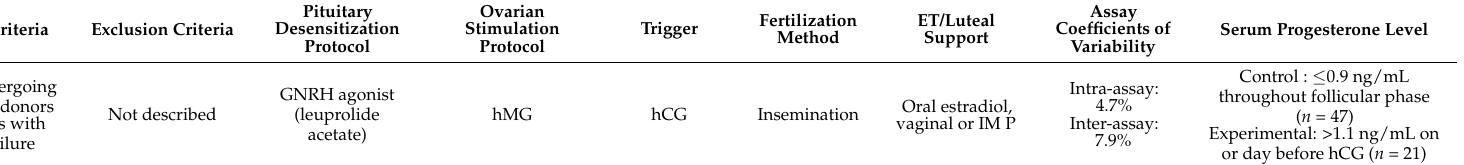
Table 3. Assessing the impact of progesterone levels on oocyte and embryo